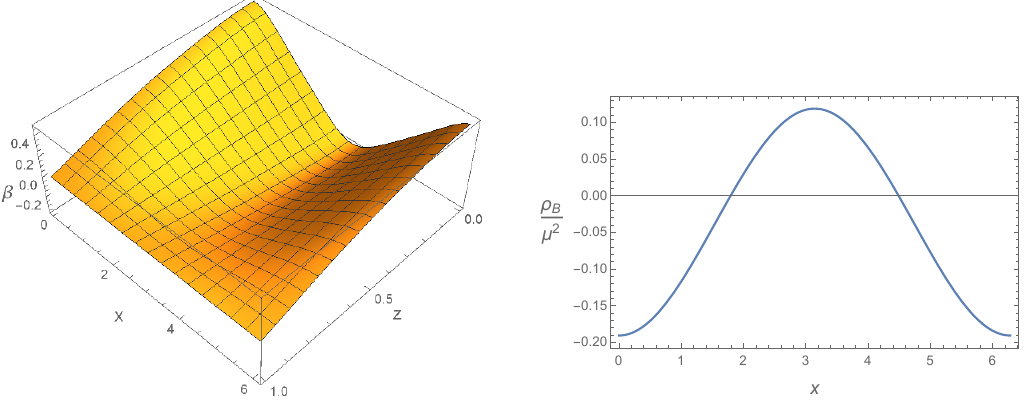
Figure 11 . Pro(cid:12)le for the gauge (cid:12)eld (cid:12) (left panel) and charge density (cid:26) B (right panel) for T = 0 : 01426 and k = 1, for the parameters chosen in (5.1) and q B = 0 : 5. In present case the average of (cid:26) B is not zero.